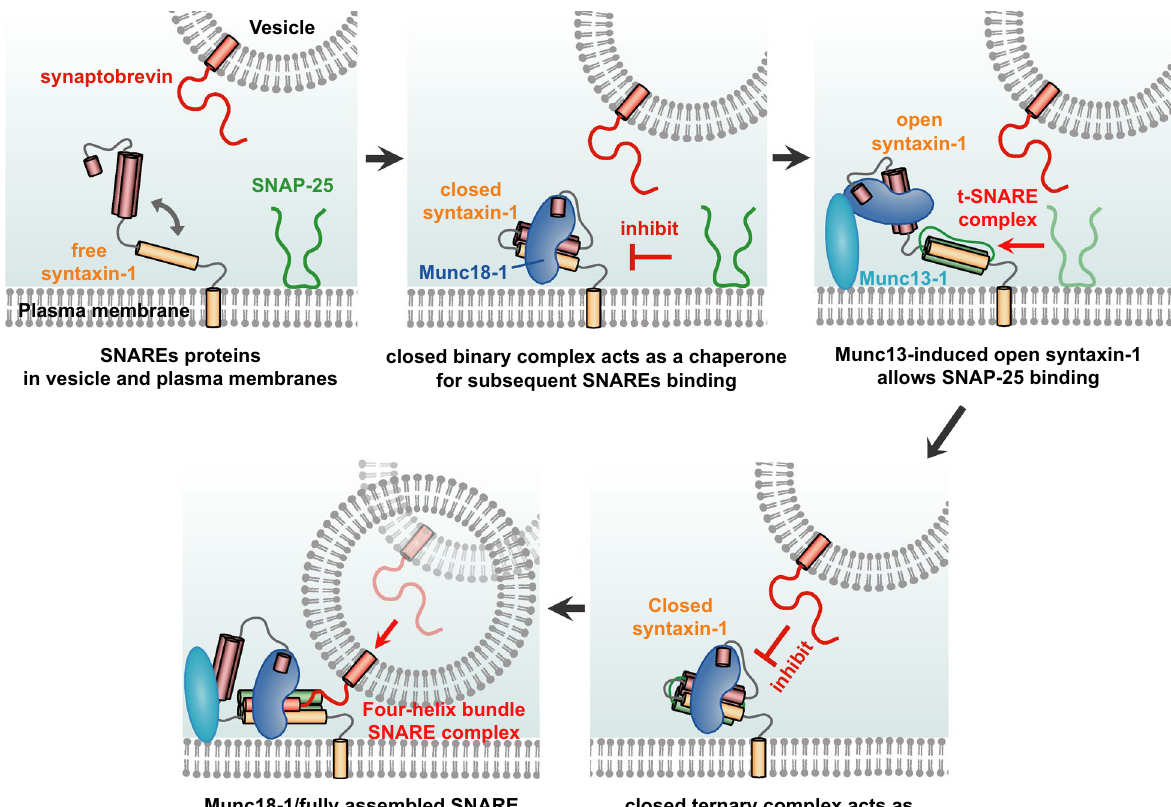
binds to syntaxin-1 with a 1:1 molecular interaction and then induces the closed conformation in syntaxin-1. This closed binary complex acts as a chaperone for the other SNAREs binding by locking the